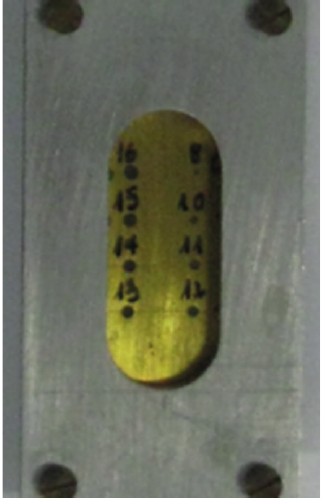
Figure 14: Example of Multi hole mask.